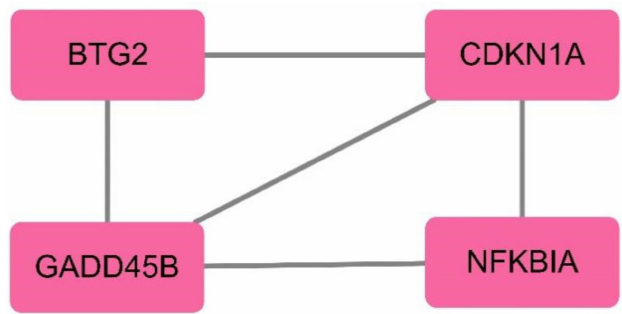
Figure 7. Cluster module extracted by MCODE.